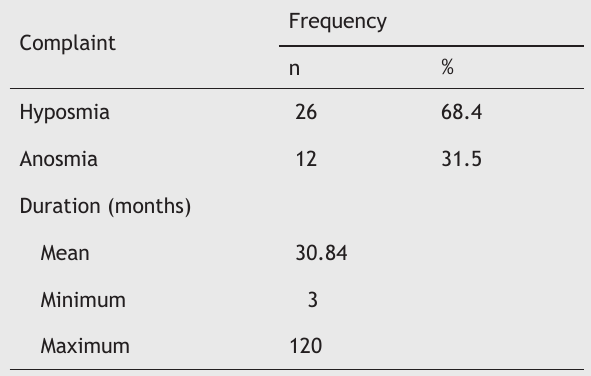
Table 2 Distribution of initial complaints and symptom